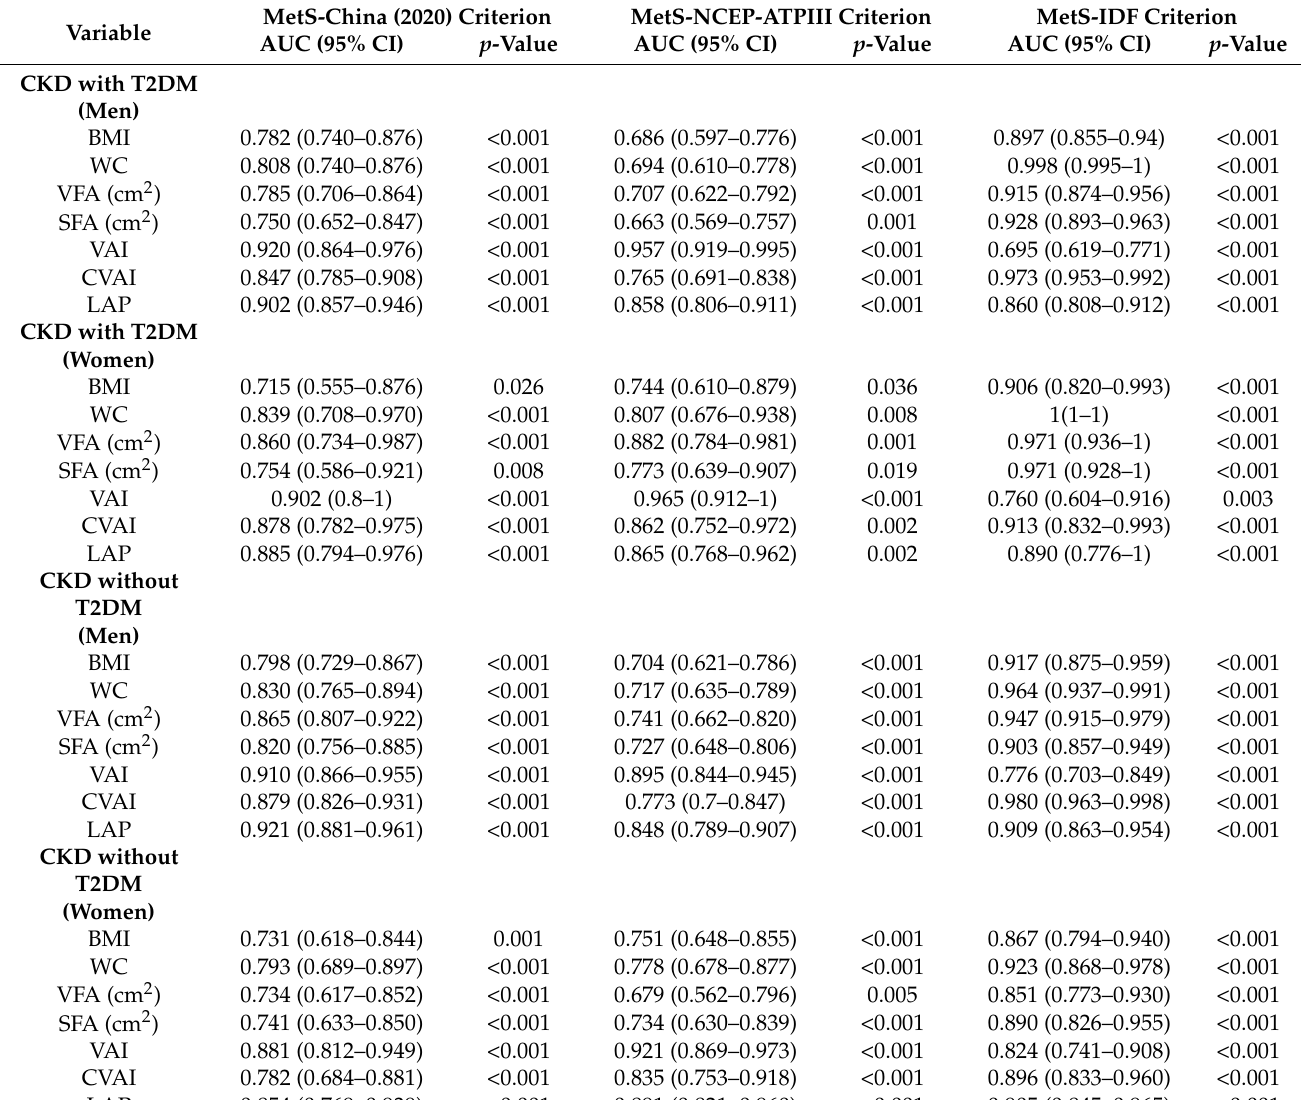
Table 4. Area under the curve of seven obesity- and lipid-related indices under different metabolic syndrome